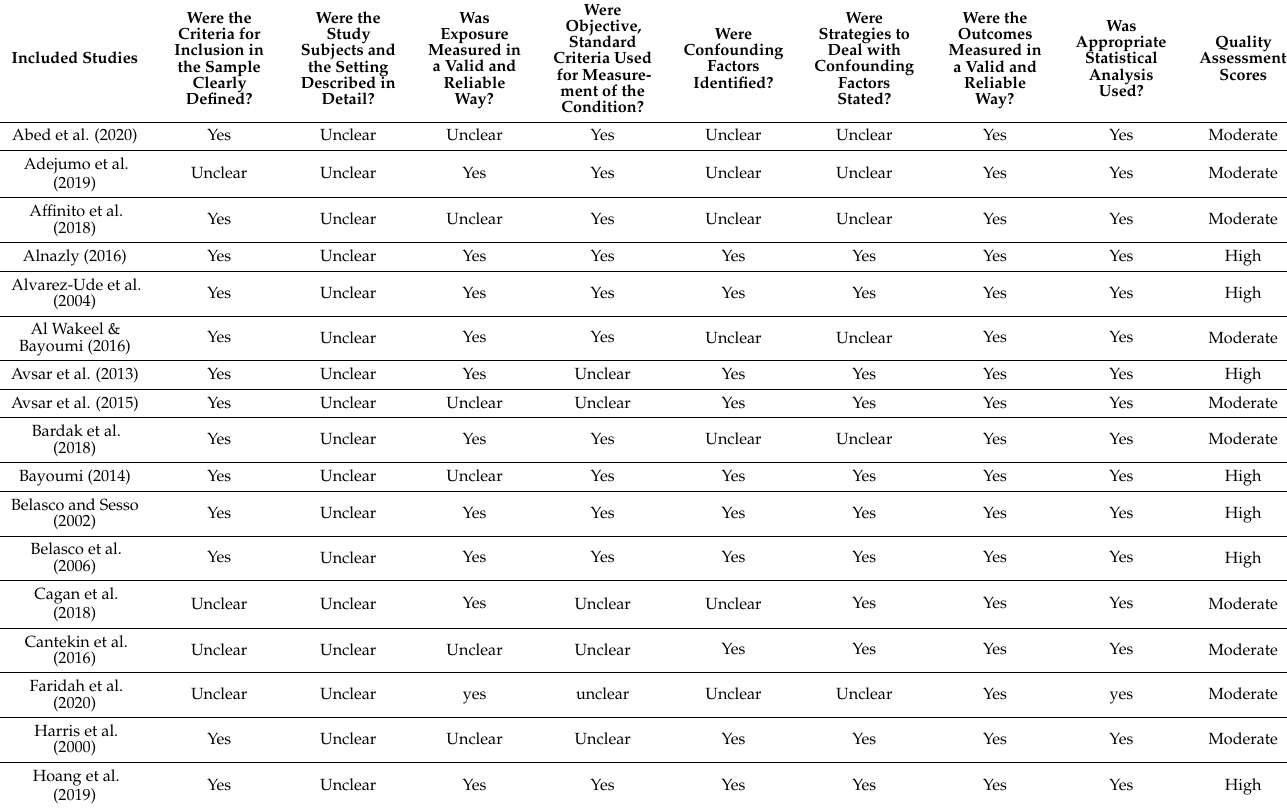
Table A1. Quality appraisal of the included studies using